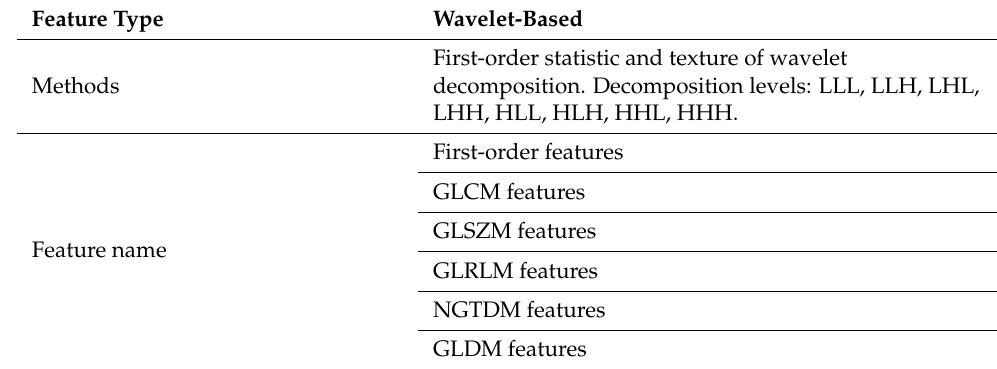
Table 3. Feature associated with the imaging